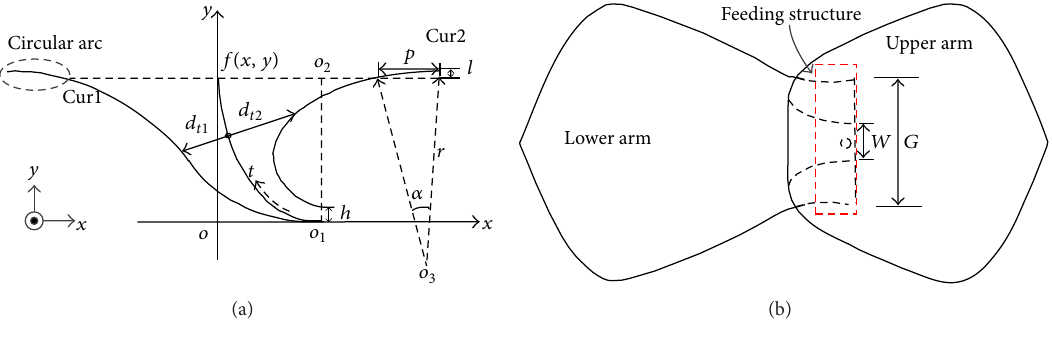
Figure 1: The geometry structure of antenna.